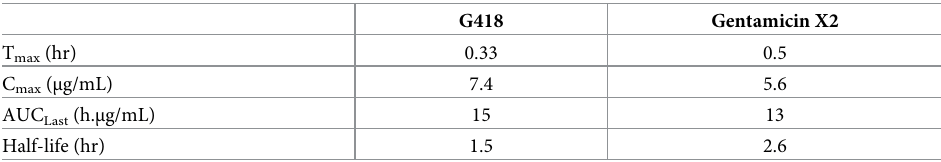
Table 3. Pharmacokinetics